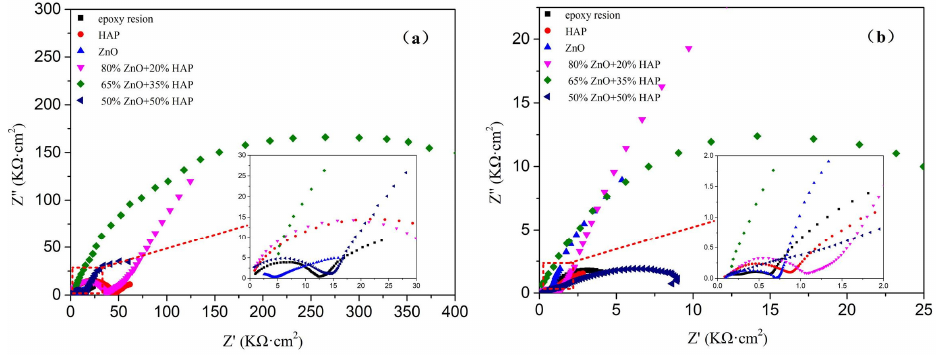
Figure 10. Nyquist plots of different coated steel samples soaked for different times: ( a ) soaked for 24